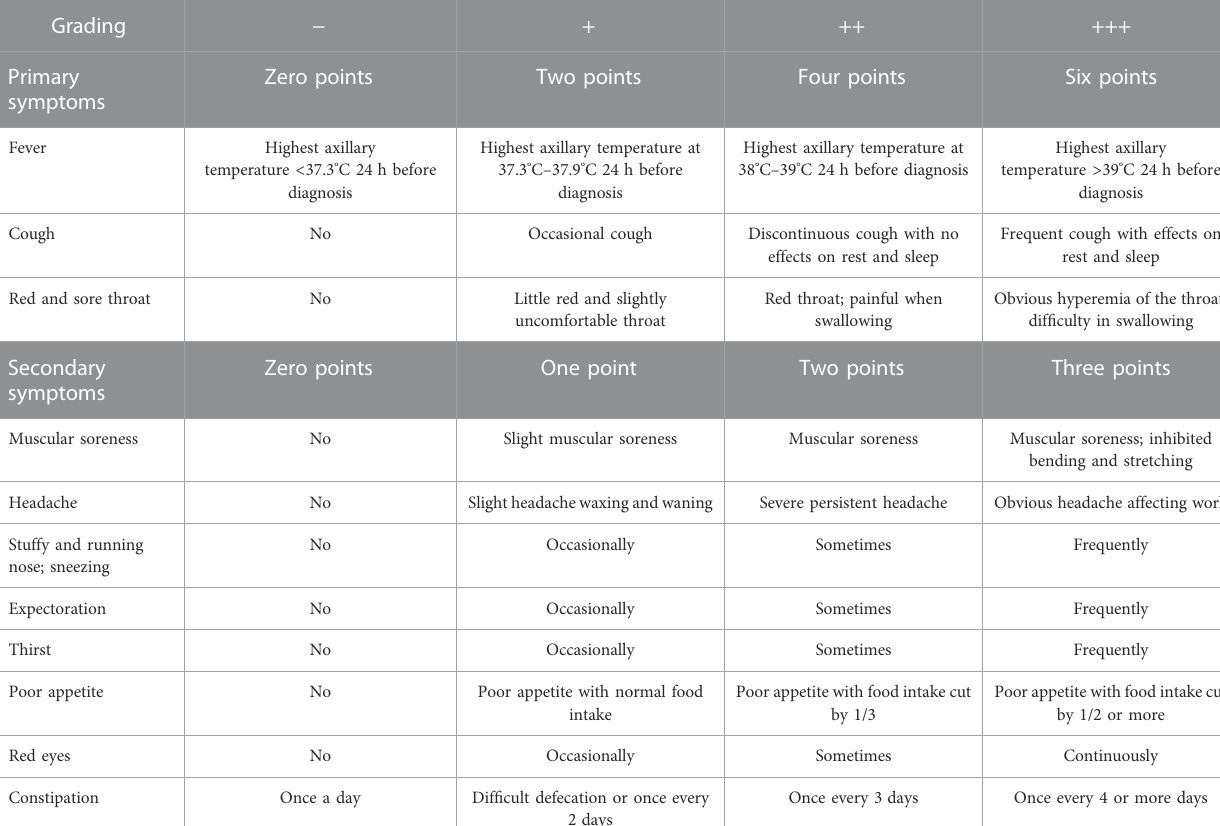
TABLE 2 Quantitative rating table for PHTS in TCM Grading